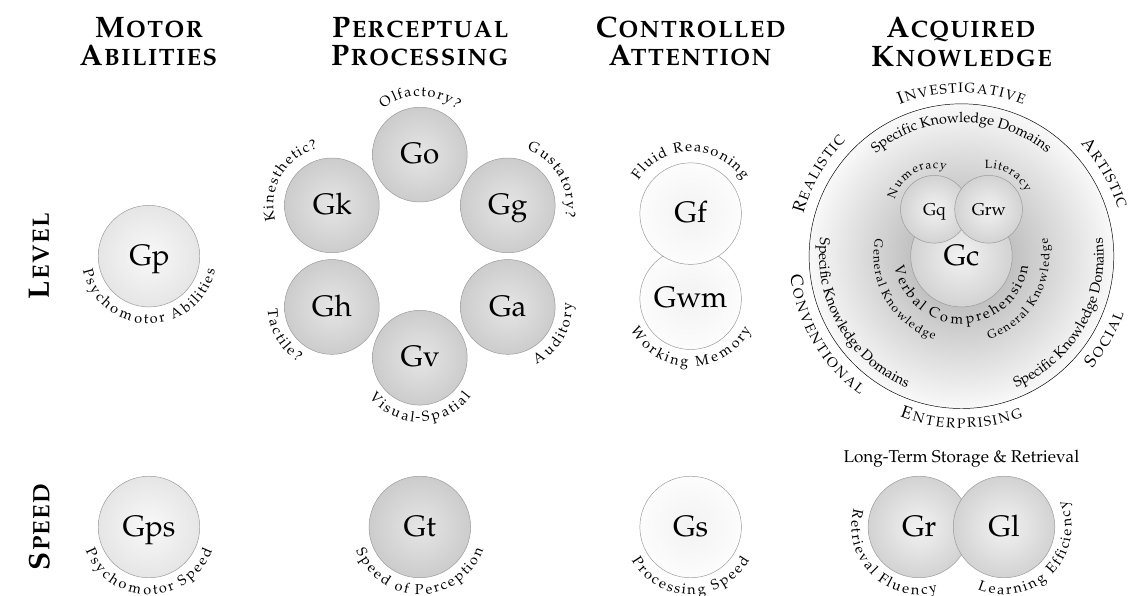
Figure 2. Conceptual Groupings of Broad Abilities in Cattell-Horn-Carroll (CHC)